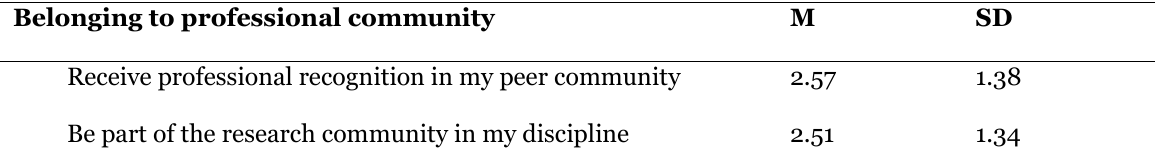
Belonging to Professional Community Belonging to professional